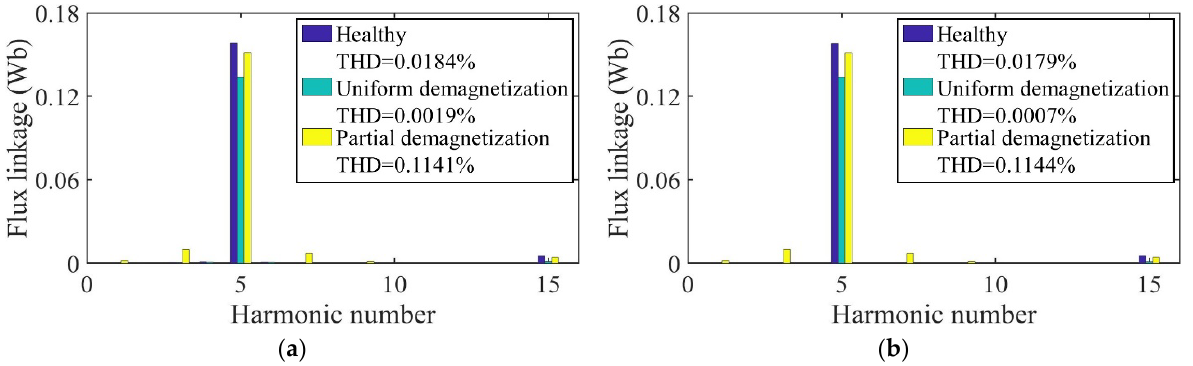
Figure 11. Harmonics in the flux-linkage relative to fundamental wave at fs = 166.67 Hz. ( a ) Analytical model; ( b ) FE model.